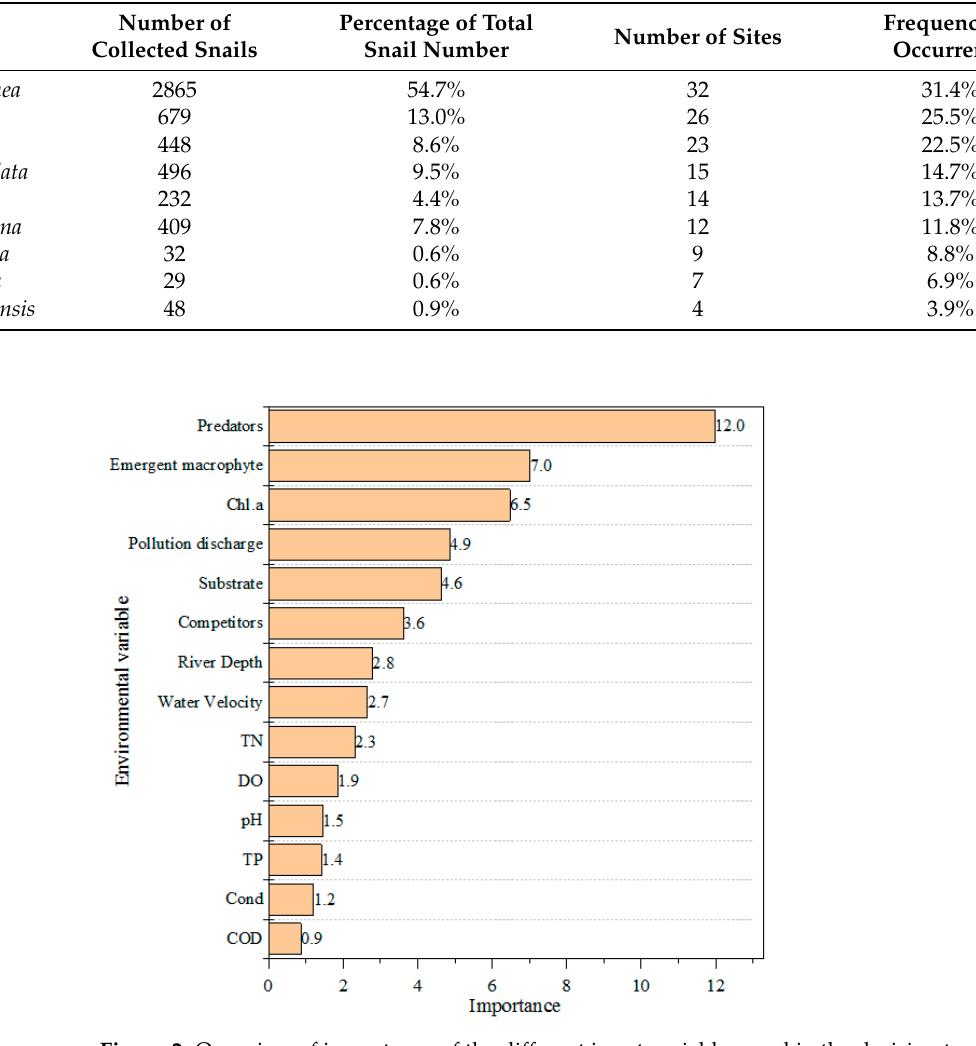
Table 3. Occurrence and abundance of freshwater snail species at 102 sampling stations in the study area. All collected snails are intermediate hosts of parasites. The frequency of occurrence is the proportion of the number of sampling sites where the snails appear to the total number of sampling sites (n = 102).